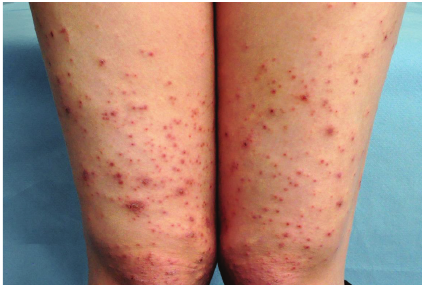
Figure 5: Prurigo lesions/excoriations and eczematous-like skin lesions in